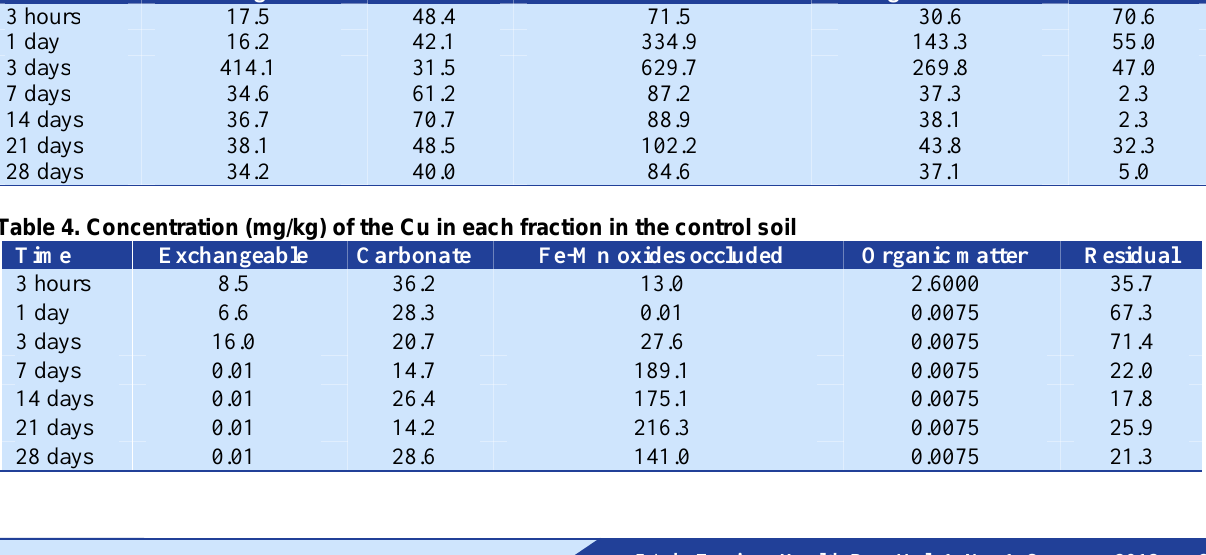
Table 3. Concentration (mg/kg) of Cu in each fraction in the contaminated soil with Actinidia deliciosa shell Time